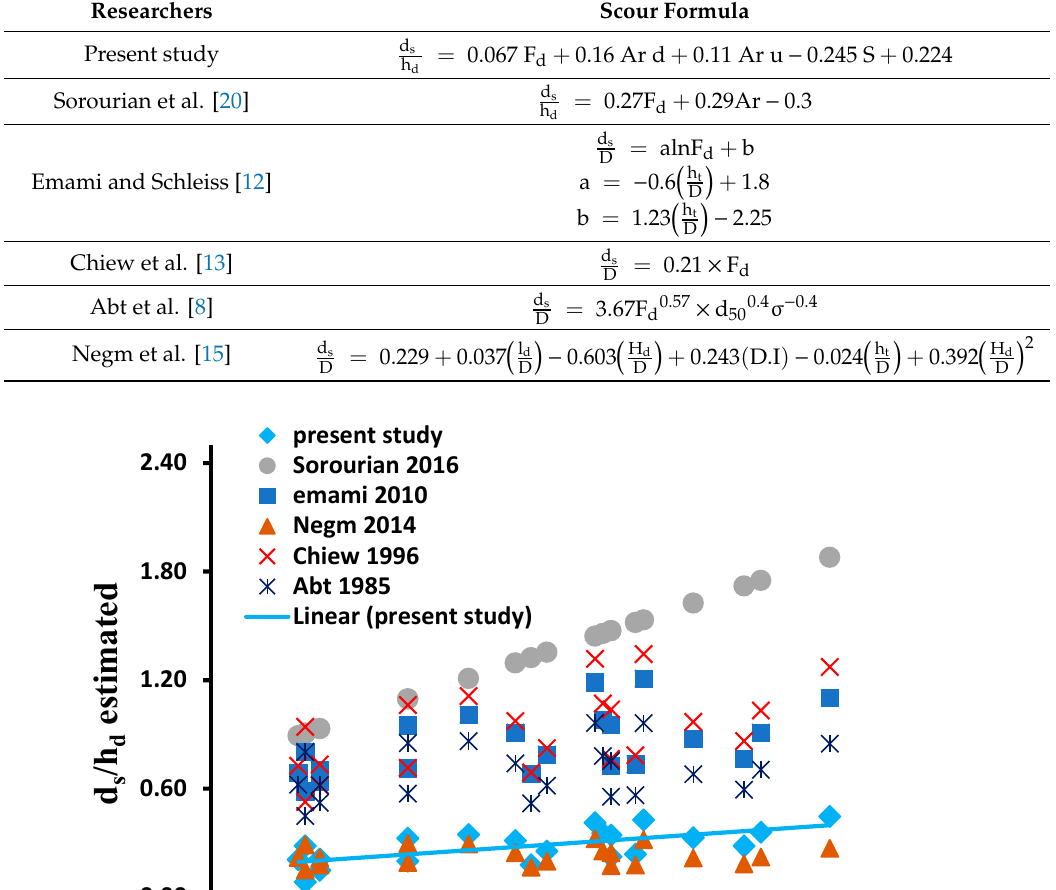
Table 2. Summary of some scour prediction formulas.